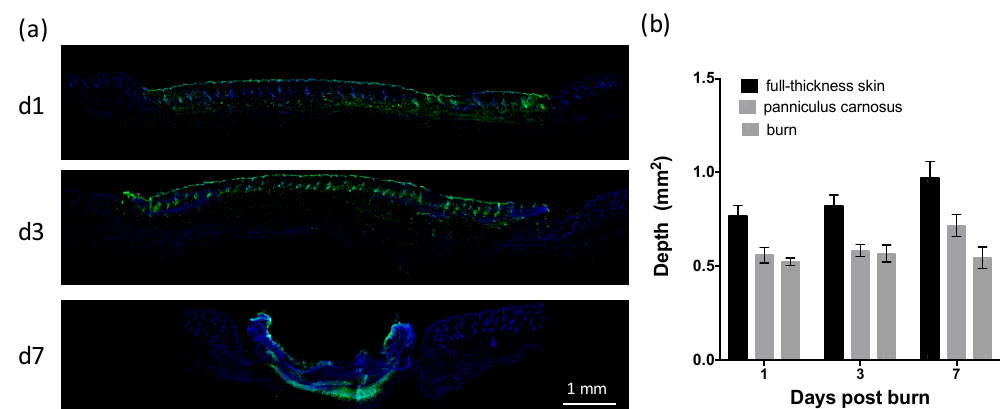
Figure 2. Application of a heated metal rod results in a partial-thickness skin burn. ( a ) Images of healing skin sections with terminal deoxynucleotidyl transferase-mediated deoxyuridine triphosphate nick-end labelling (TUNEL) at the indicated day post thermal burn. Scale is as indicated. ( b ) Burn depth over time is shown relative to the depth of full-thickness skin and the panniculus carnosus. Data represents the mean ± SEM, n = 6.